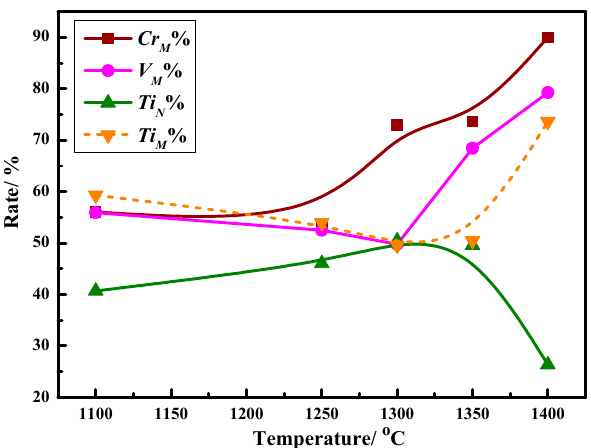
Figure 10. The effect of temperature on the transformation patterns of V, Ti, and Cr.